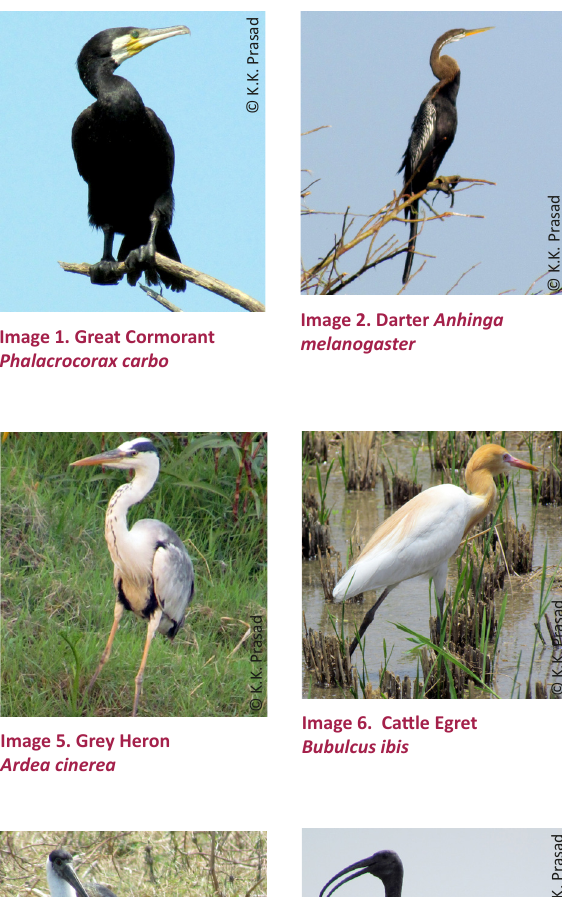
Image 11. Glossy Ibis Plegadis falcinellus